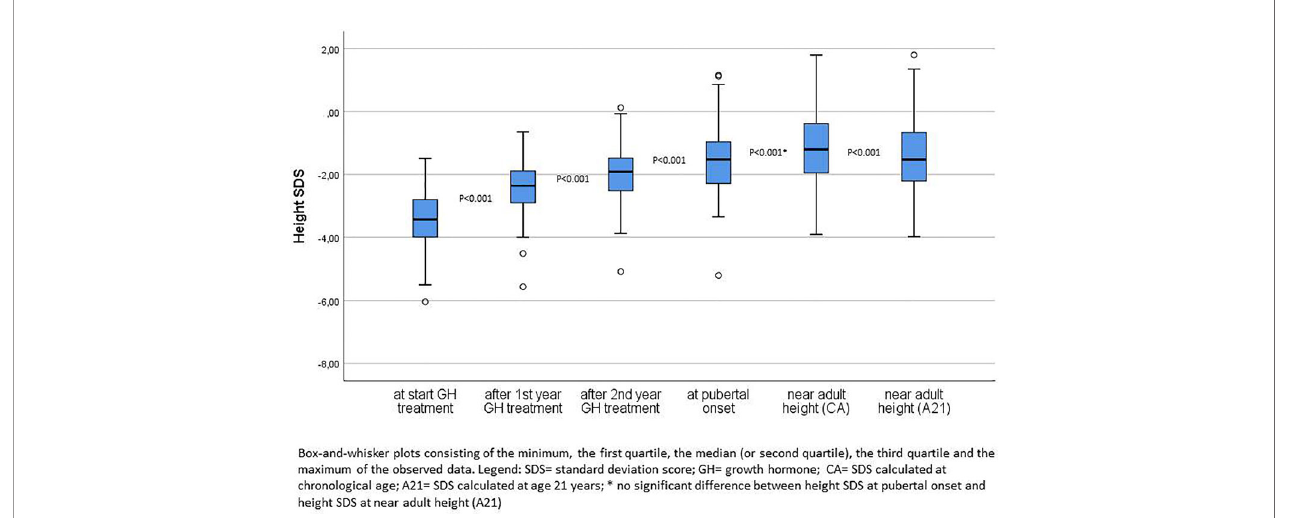
FIGURE 2 | Height SDS at start of GH treatment, after fi rst and second years of GH treatment, at pubertal onset and near adult height.